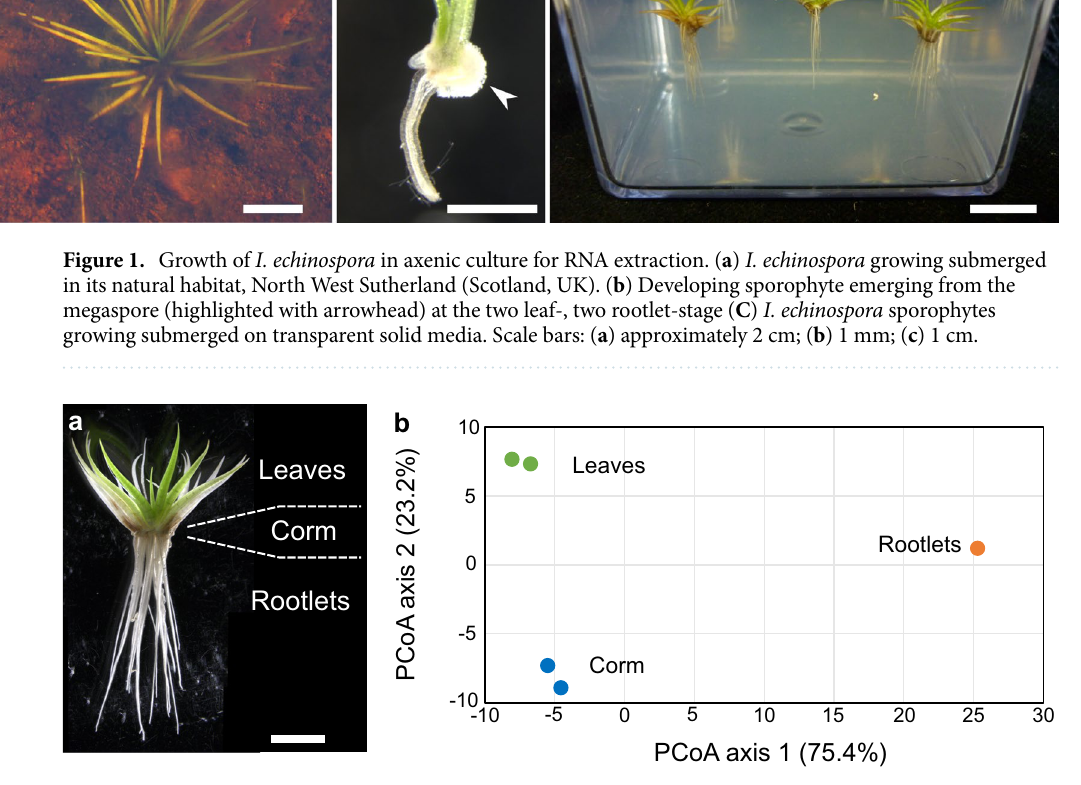
Figure 2. Gene expression profiles of leaves and rootlets are different in I. echinospora . ( a ) I. echinospora sporophyte at the stage when RNA was extracted from rootlets, corms and leaves. Scale bar 5 mm. ( b ) Comparison of gene expression profiles by principle coordinate analysis (PCoA) in the transcriptome of I. echinospora . Two technical replicates of gene expression profiles of the corm and leaves and single replicate of rootlets of I. echinospora. Two leaf replicates, green. Two corm replicates, blue. Single root replicate, orange. Values on PCoA axes are shown in thousands. Values in brackets on each axis describe the percentage of total variance accounted for by each